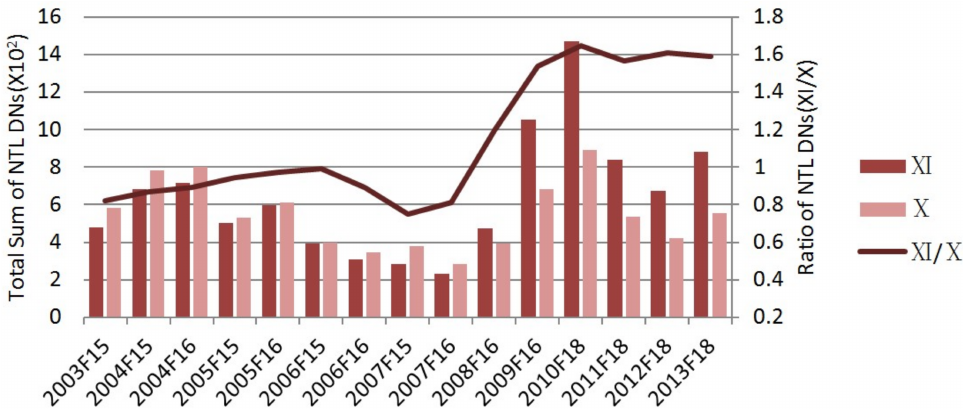
Figure 9. The change contrast in the total sum of NTL in the XI and X regions.